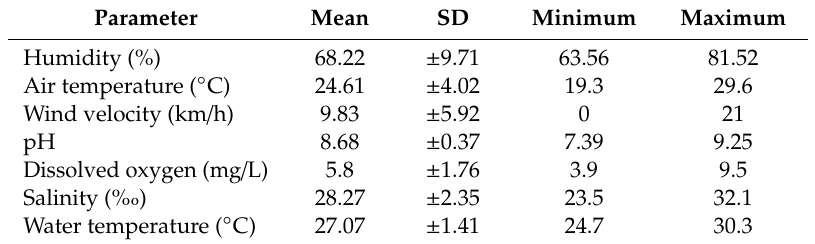
Table 1. Mean, Standard Deviation, Minimum and Maximum values of the abiotic parameters during the study